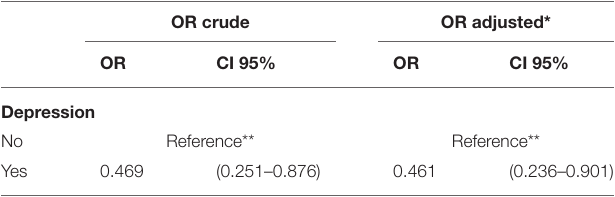
TABLE 3 | Binary logistic regression [OR (95% CI)] between depression and highest quartile of selenium consumption, gender, marital status, socioeconomic class, alcohol consumption, and pesticide poisoning in Brazilian